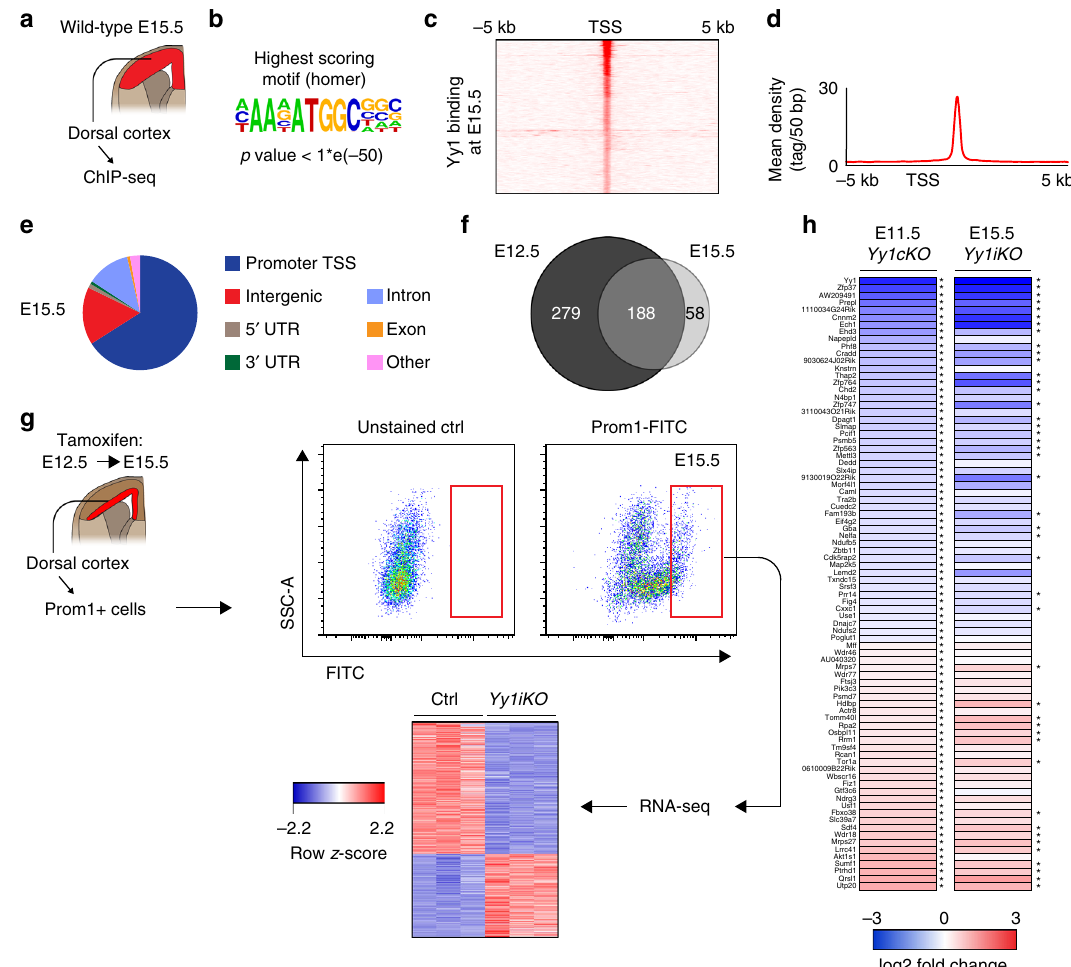
Fig. 7 Yy1 controls a similar gene set throughout cortex development. a Genome-wide binding of Yy1 to DNA regions was analyzed by chromatin immunoprecipitation followed by deep sequencing (ChIP-seq) of cortex cells derived at E15.5. Statistical analysis of the enriched regions identi fi ed 246 binding events at E15.5 (FDR< 0.001), present in at least 1 of 2 replicas. b Homer motif discovery revealed the known Yy1-binding motif as the highest scoring motif ( p < 1*e-50). c – e Read cluster pro fi le and distribution of binding sites to different genomic locations at E15.5. Yy1 binds preferentially to the promoter region of the transcription start site (TSS) of genes. f Analysis of overlap between E12.5 and E15.5 ChIP-seq data. g RNA-seq comparing E15.5 Yy1iKO vs control (each n = 3 embryos) radial glia cells from the dorsal cortex which were isolated by microdissection and subsequent Prominin1-based (CD133-FITC) FACS. A total of 1080 genes were downregulated (660 genes) or upregulated (420 genes) upon induced knockout of Yy1 (|log2 fold change|>0.32, p <0.05, FDR< 0.05). h RNA-seq expression of genes at E11.5 and E15.5, which are bound by at E12.5 and E15.5, upon knockout of Yy1. * p